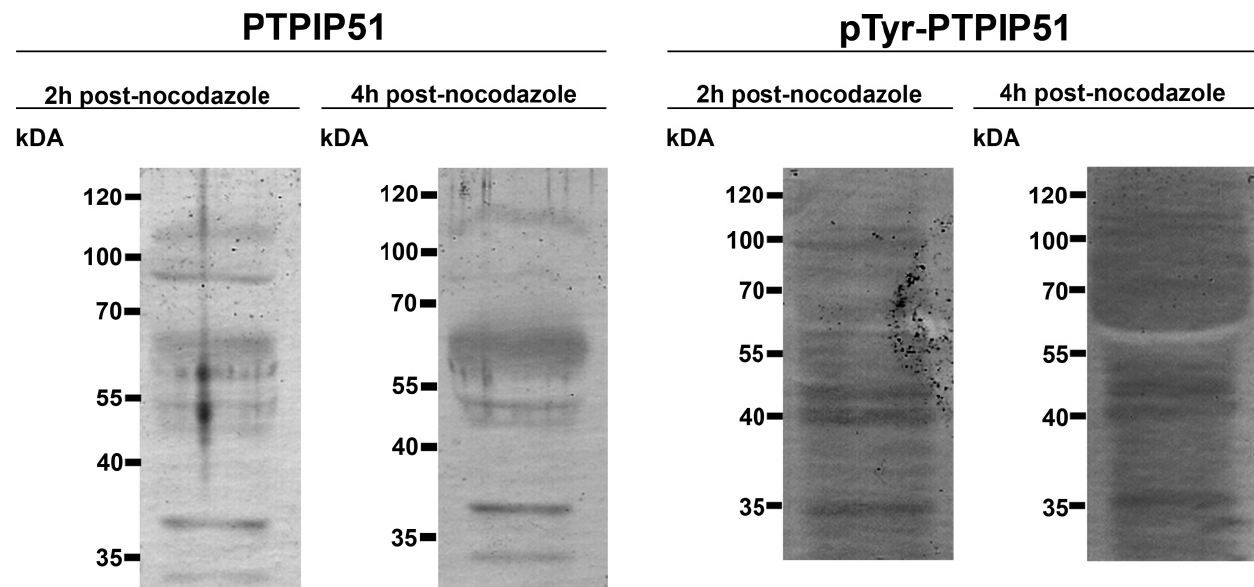
Figure 4. Immunoblot of nocodazole treated HaCat cells. Cell lysate was analyzed at 2 h and 4 h post-nocodazole. PTPIP51 antibody: